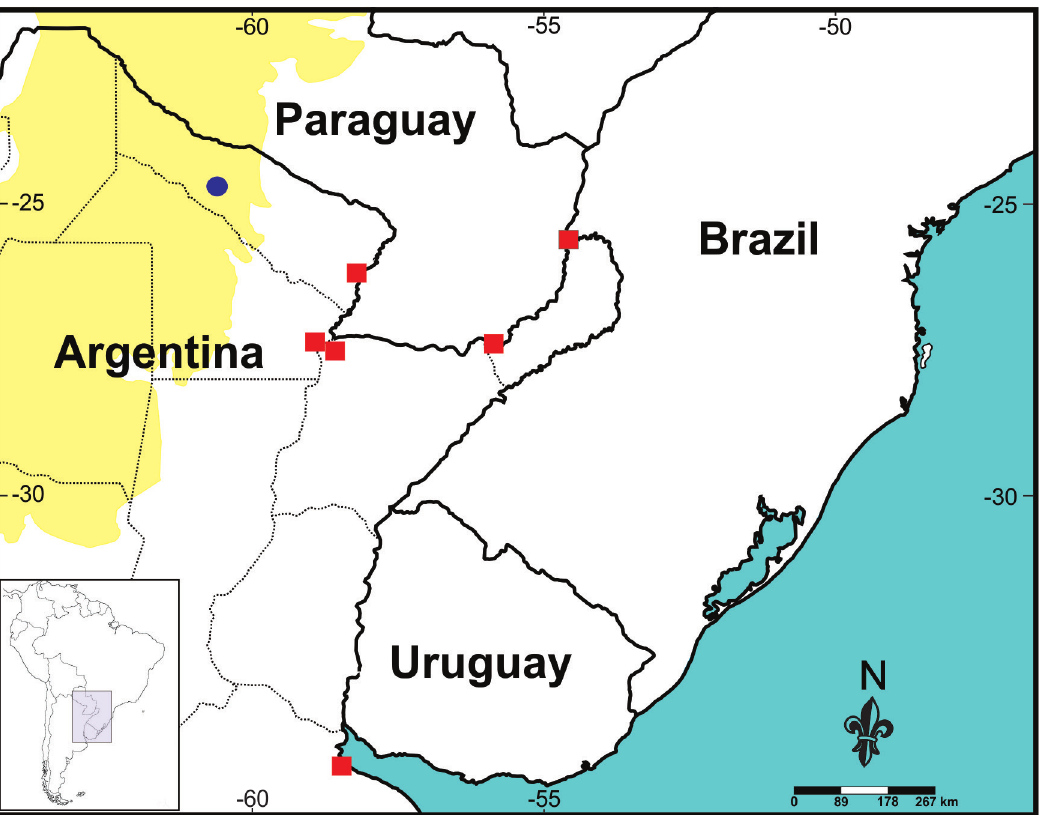
Figure 1. Distribution map of H. mabouia in Argentina. The blue solid circle indicates the new record. Red solid squares indicate previous records. The light yellow shaded area corresponds to the dry Chaco biogeographic